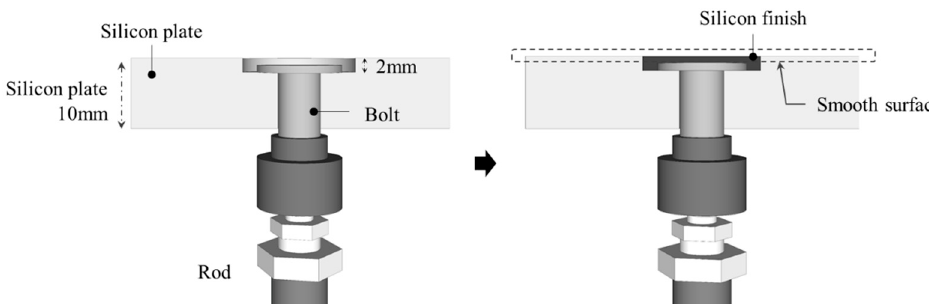
Figure 4. Combining the silicone plate and rod.